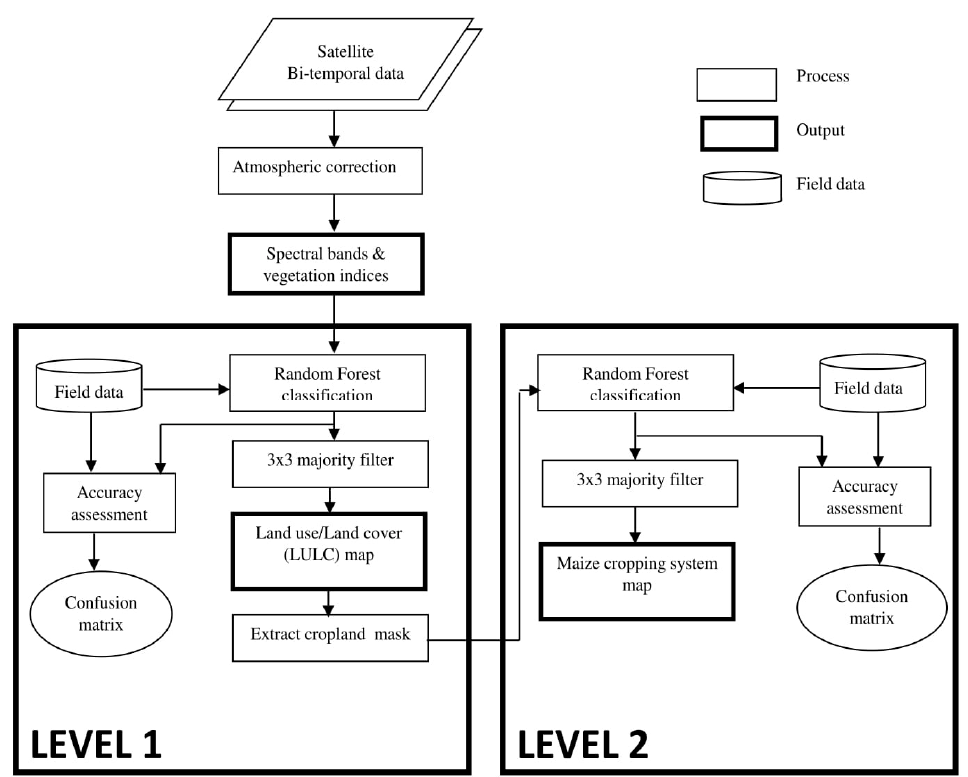
Figure 2. Flow chart of the hierarchical classification approach using random forest (RF) classifier and Bi-temporal RapidEye data.